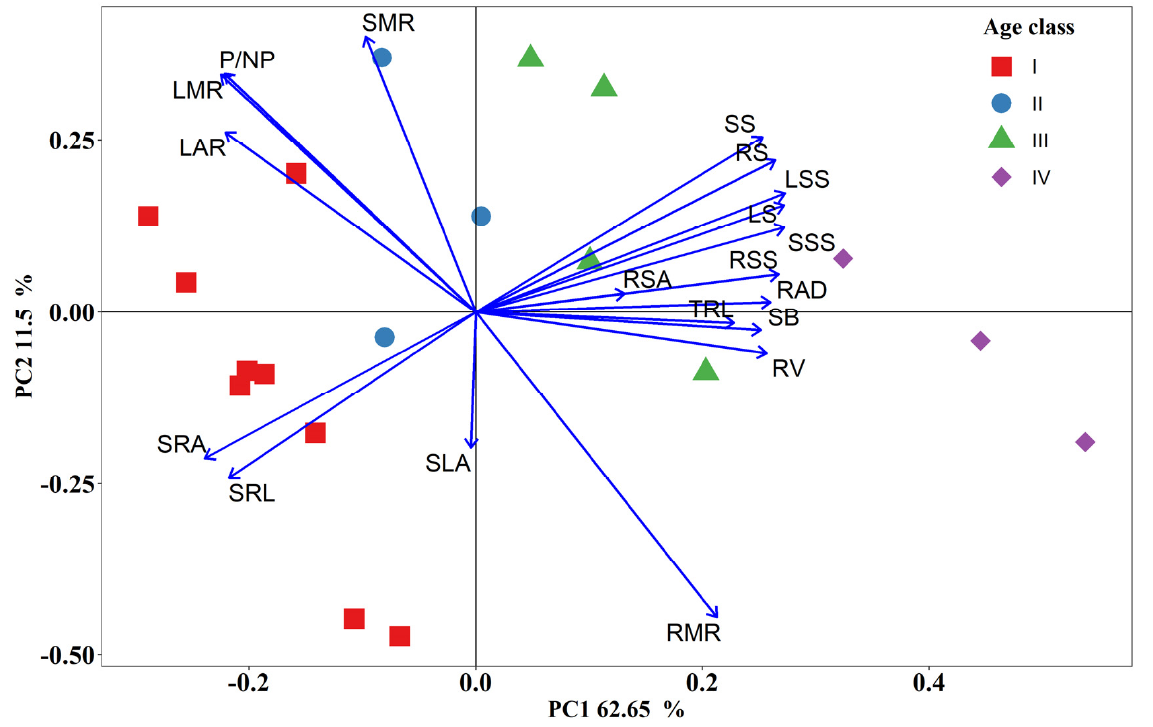
Figure 9. Principal component analysis of Quercus acutissima seedling trait. SB: seedling biomass; LMR: leaf mass ratio; RMR: root mass ratio; SMR: stem mass ratio; SLA: specific leaf area; LAR: leaf area ratio; TRL: total root length; RSA: total root surface area; RV: root volume; RAD: root average diameter; SRL: specific root length; SRA: specific root area; P/NP: photosynthetic tissues/ non-pho- tosynthetic tissues; RSS: root soluble sugar; SSS: stem soluble sugar; LSS: leaf soluble sugar; RS: root starch; SS: stem starch; LS: leaf starch.